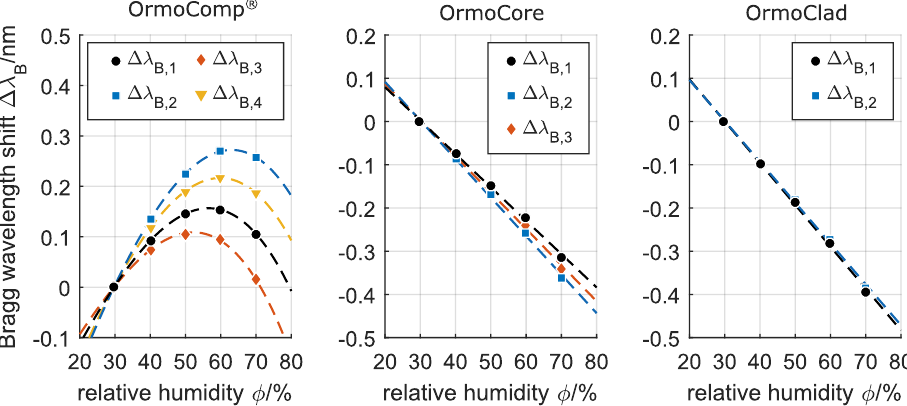
Figure 6. Dependence of the planar waveguide Bragg gratings in OrmoComp ® , OrmoCore, and OrmoClad on the relative humidity at a temperature θ of 30 ◦